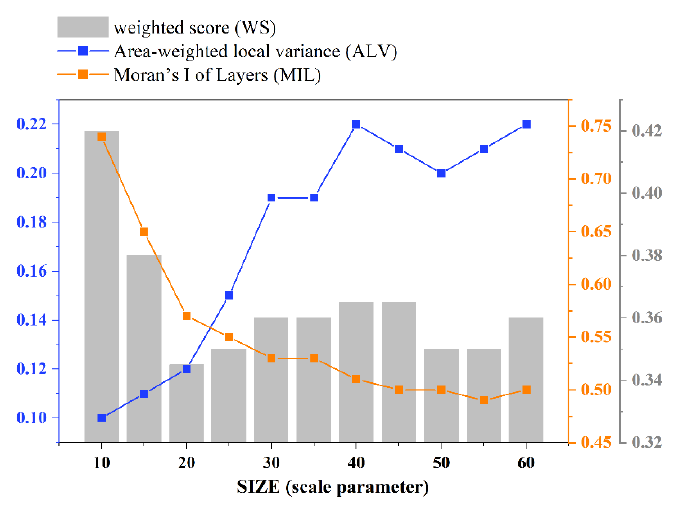
Figure 4. Sensitivity analysis of the scale parameter (size) measured by the area-weighted local variance (ALV), Moran’s I of layers (MIL), and weighted score (WS).